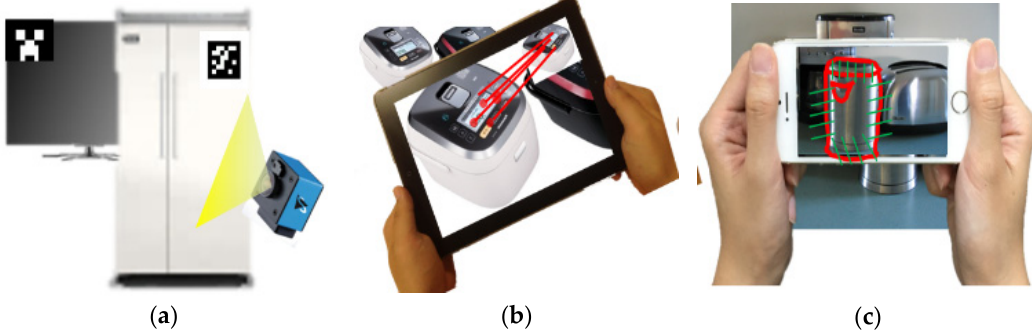
Figure 8. Main object recognition and tracking solutions for augmented reality (AR): ( a ) marker / fiducial, ( b ) feature, and ( c ) model ‐ based.